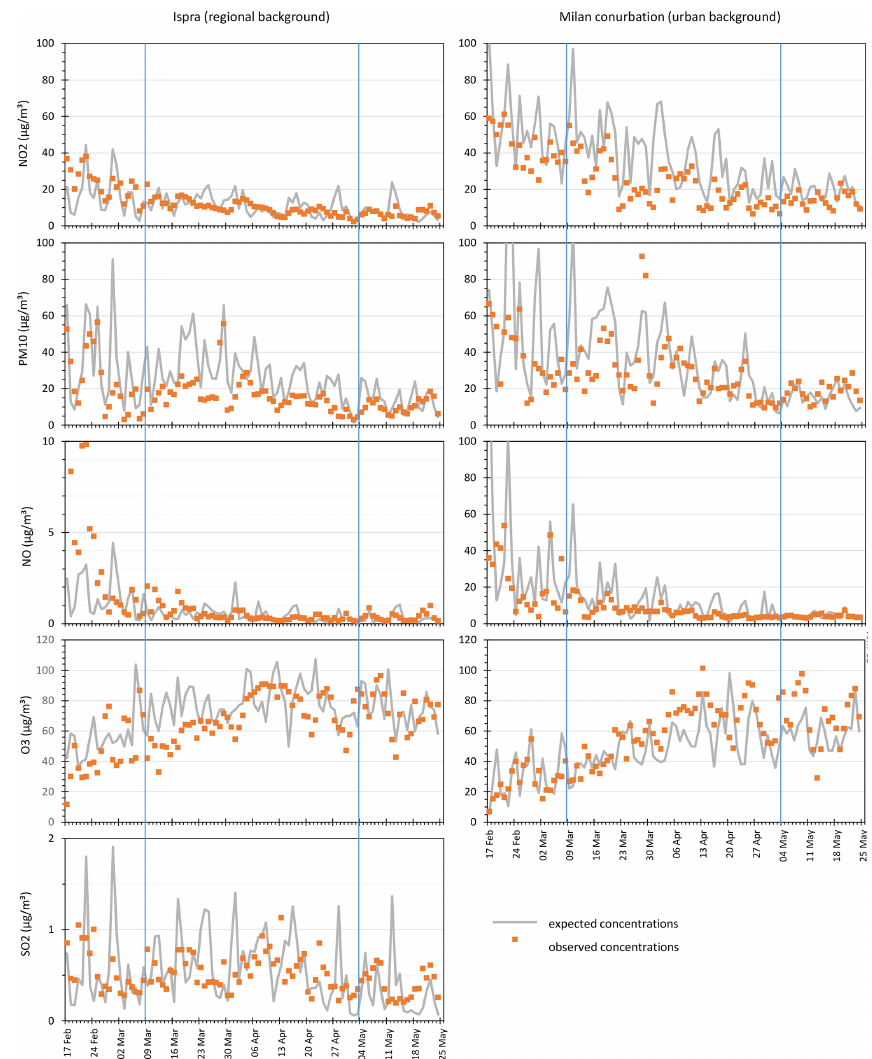
Figure 3. Observed (dots) and expected (lines) 2020 concentrations (µgm − 3 ) of NO 2 , PM 10 , NO, O 3 and SO 2 in Ispra (left-hand side) and the Milan conurbation (right-hand side). Vertical lines indicate the beginning and end of the lockdown period. Table 1. Observed / expected concentration ratios for pollutant concentrations and aerosol characteristics before, during and after the lock- down measures in Ispra (regional background) and Milan (urban background). Ispra (regional background) Milan (urban background) Before During During After Before During During After ( > median) ( >